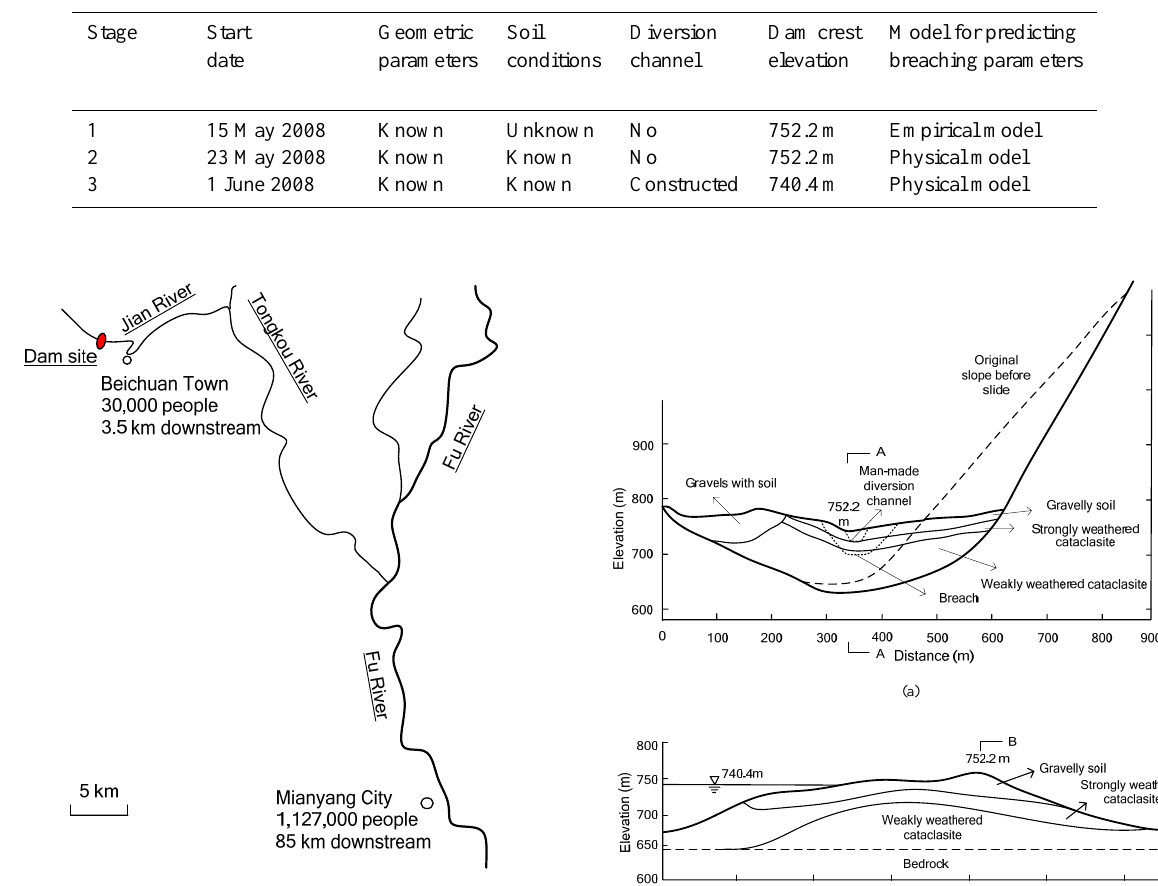
Table 2. Available information in the three stages of decision making for Tangjiashan landslide dam.